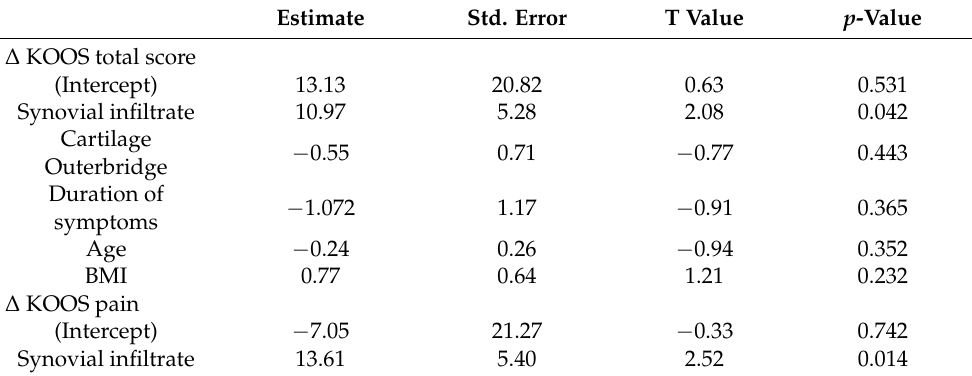
Table 3. Multivariate linear regression models between clinical outcomes ( ∆ KOOS and ∆ VAS) and synovial infiltrate and other OA risk factors as dependent